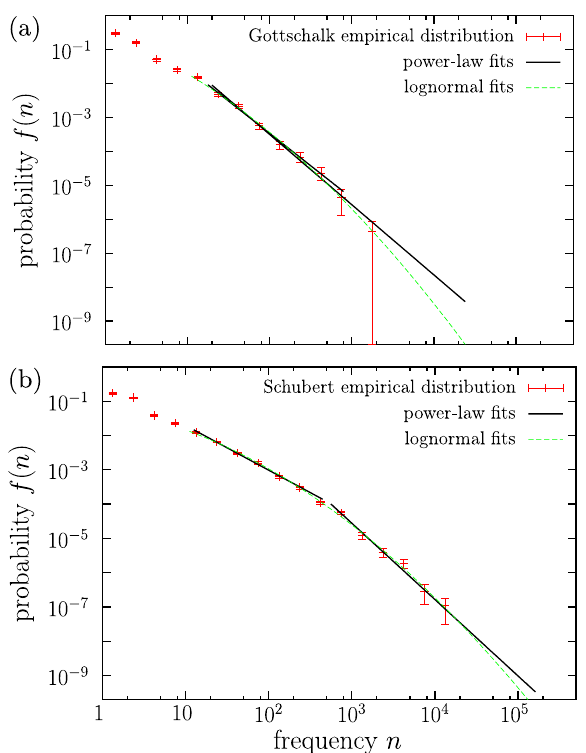
Figure 5. Empirical probability density of codeword frequency for ( a ) Gottschalk and ( b ) Schubert, together with their fits. Gottschalk is the composer with the largest logarithmic fitting range for the simple power law, nevertheless, the (logarithmic) fitting range for the lognormal is larger. Schubert has the largest number of types in the lognormal fitting range (1102). Failed double-power law fits are also